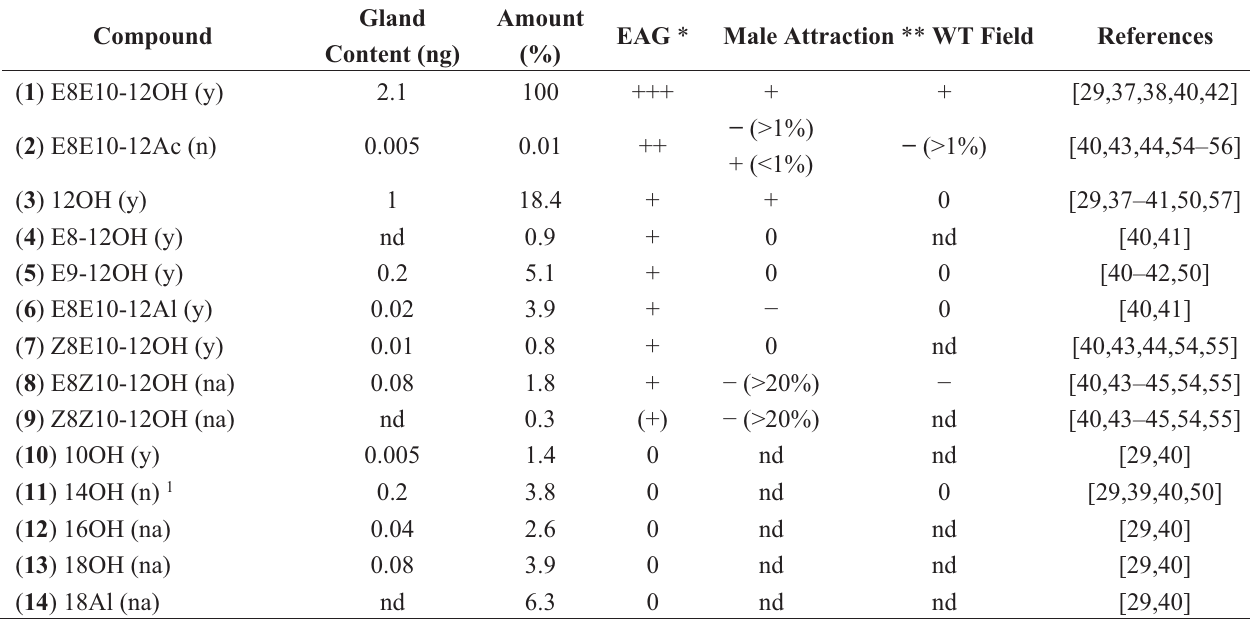
Table 1. Female sex pheromone gland content and male response to pheromone components in Cydia pomonella in the